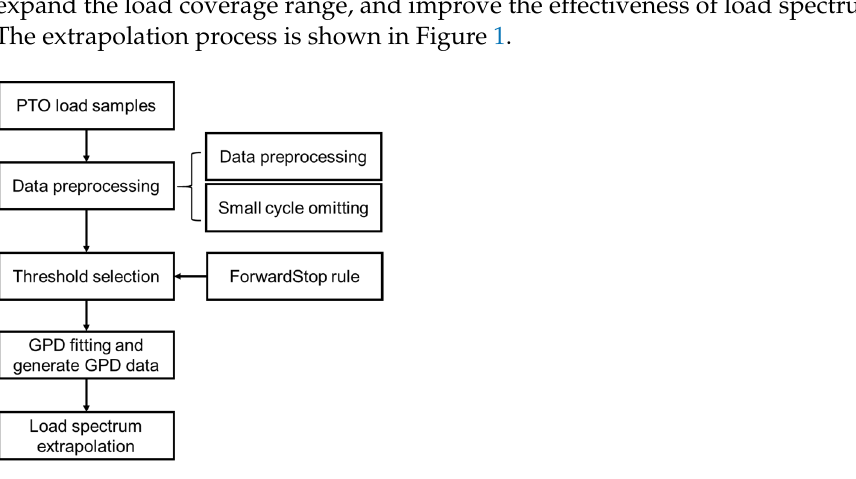
Figure 1. Extrapolation process based on Peak Over Threshold theory.